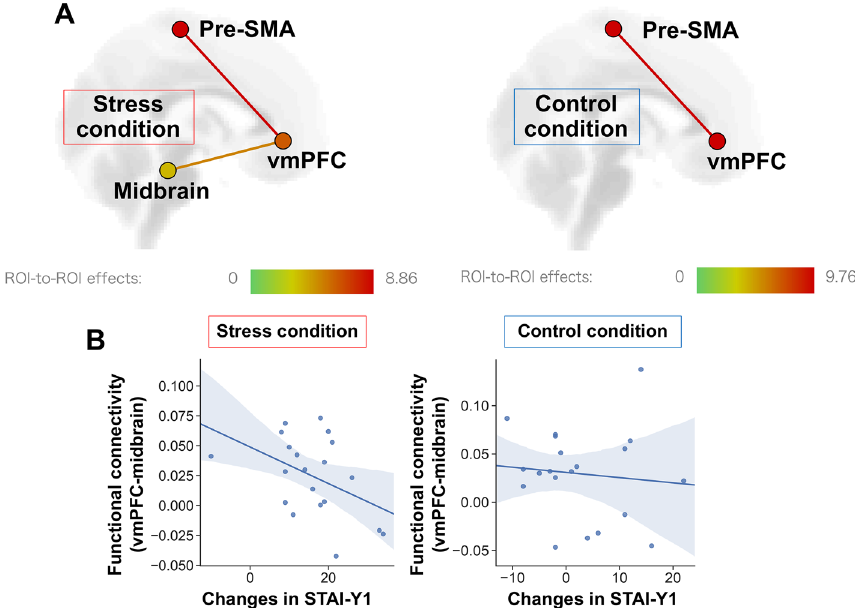
Figure 6. ROI-to-ROI analysis. ( A ) Functional connectivity between targeted areas (left, stress condition; right, control condition). Significant functional connectivity between the vmPFC and midbrain were observed only in the stress condition. The colour bar of ROI-to-ROI effects indicates the F-value. ( B ) Correlation plot of functional connectivity between the vmPFC and midbrain against a change in the state anxiety in the stress condition (r = − 0.45, P = 0.048) and the control condition (r = − 0.1, P = 0.67). Lines and coloured areas are the regression line and the 95% confidence interval, respectively. The images were created by using the